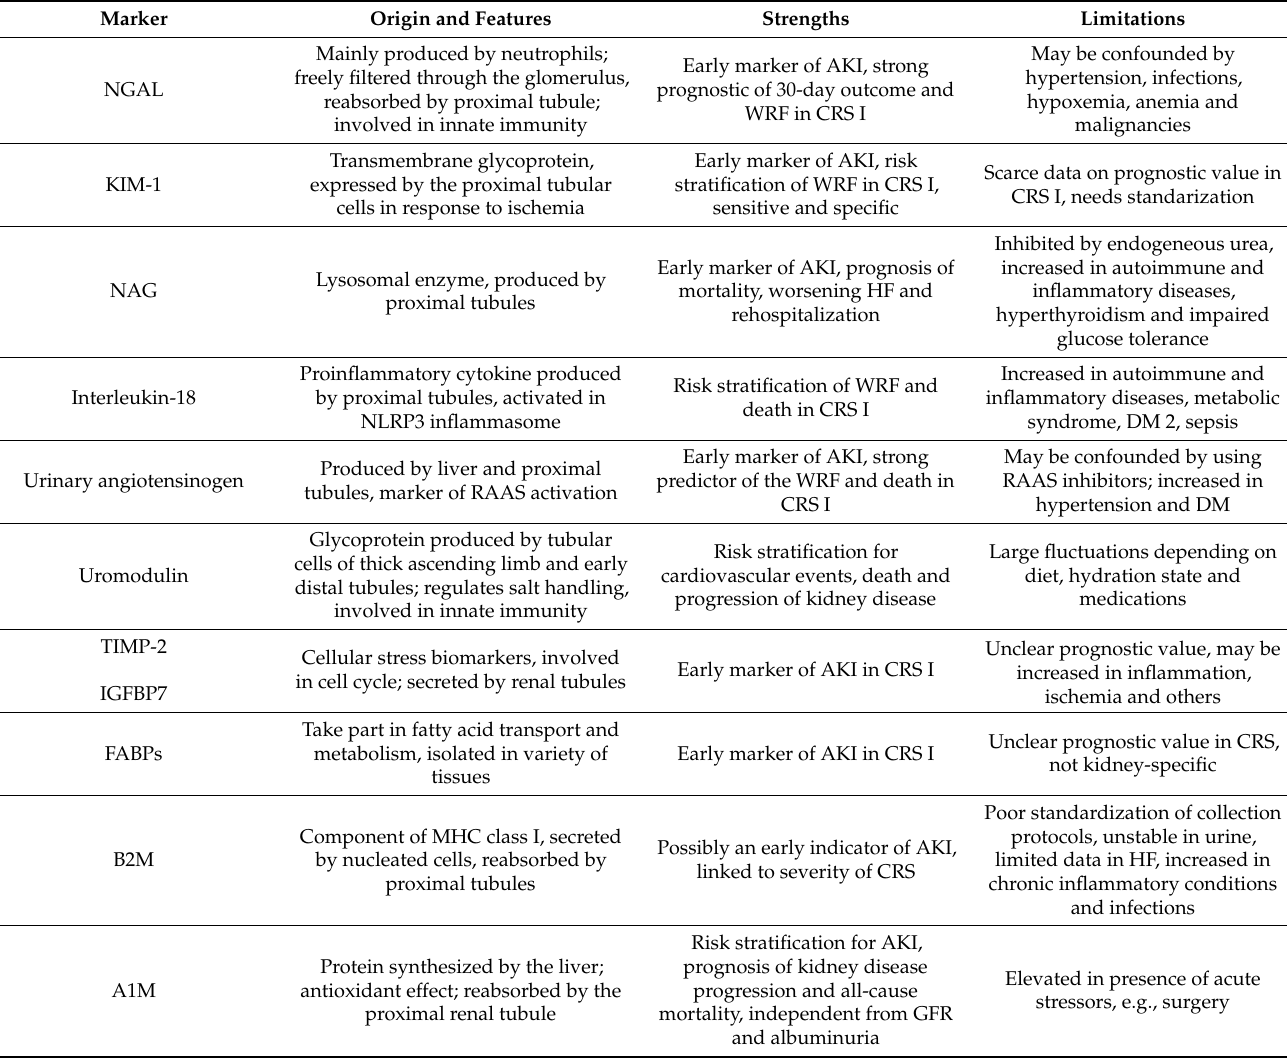
Table 3. Characteristics of tubular injury